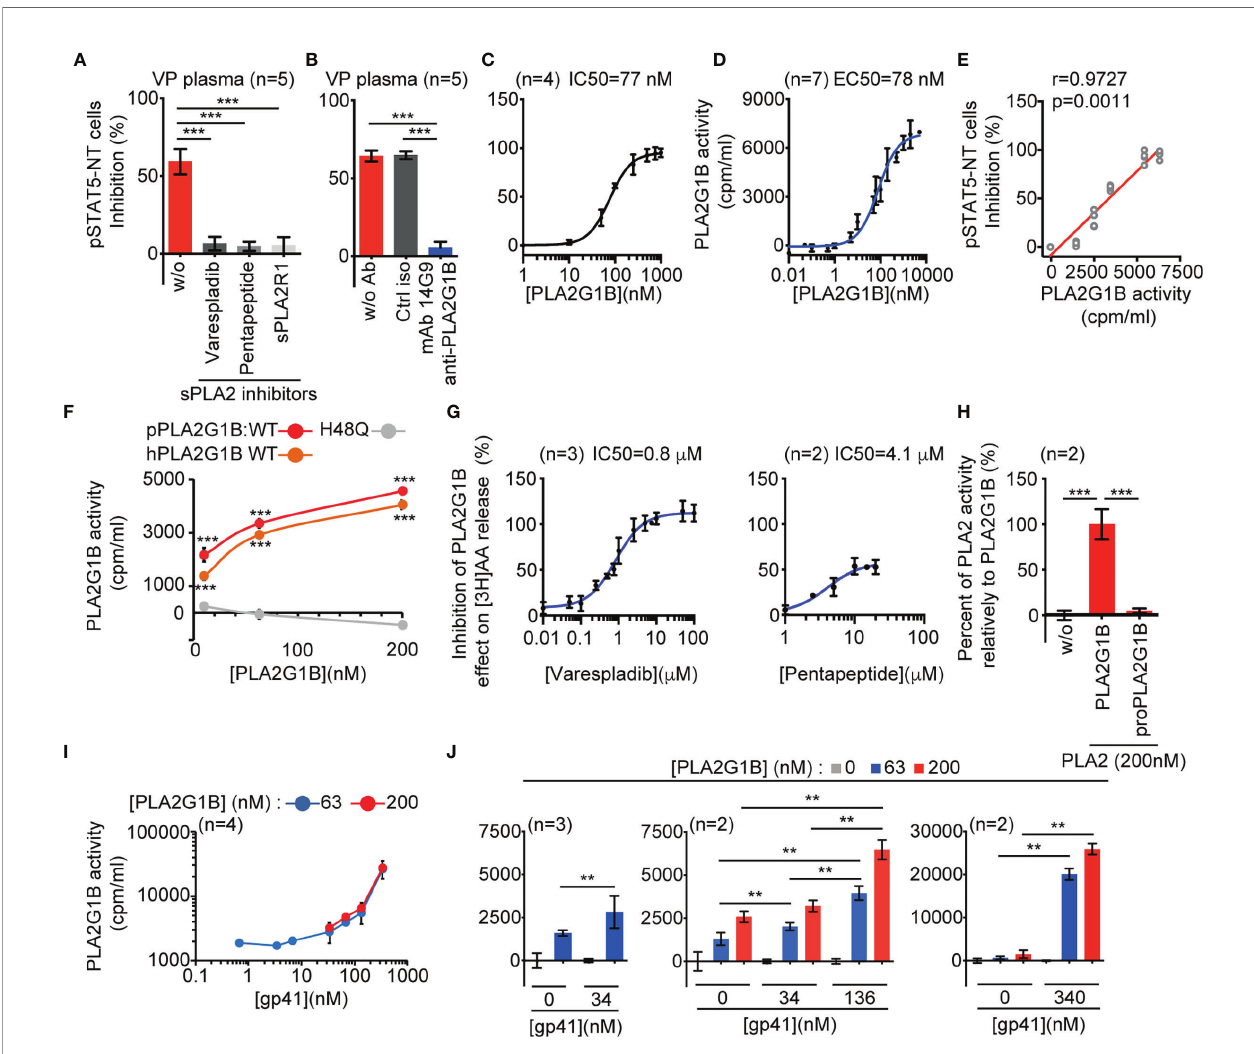
FIGURE 1 | HIV gp41 protein increases PLA2G1B enzymatic activity on CD4 T-cell membranes. (A, B) The sPLA2 inhibitors varespladib, pentapeptide, and sPLA2R1 and the anti-PLA2G1B mAb 14G9 strongly inhibit PLA2G1B activity in HIV viremic plasma. Puri fi ed HD CD4 T cells from two donors (A) and three donors (B) were treated with 3% of VP plasma from fi ve viremic HIV patients together with varespladib (50 µM), pentapeptide (15 µM), sPLA2R1 (160 nM), or not (A) or control isotype (ctrl iso) or 14G9 mAb (667 nM, B) and the pSTAT5-NT cell response to IL-7 was analyzed by confocal microscopy. (C) PLA2G1B inhibits the pSTAT5-NT cell response to IL-7 in a dose-response manner. HD CD4 T cells were puri fi ed from four donors. The IC50 value is indicated. Results are shown as the mean ± SD of the percentage of pSTAT5-NT cell inhibition for A-C. (D) PLA2G1B activity can be followed in a dose-response manner on human CD4 T cells